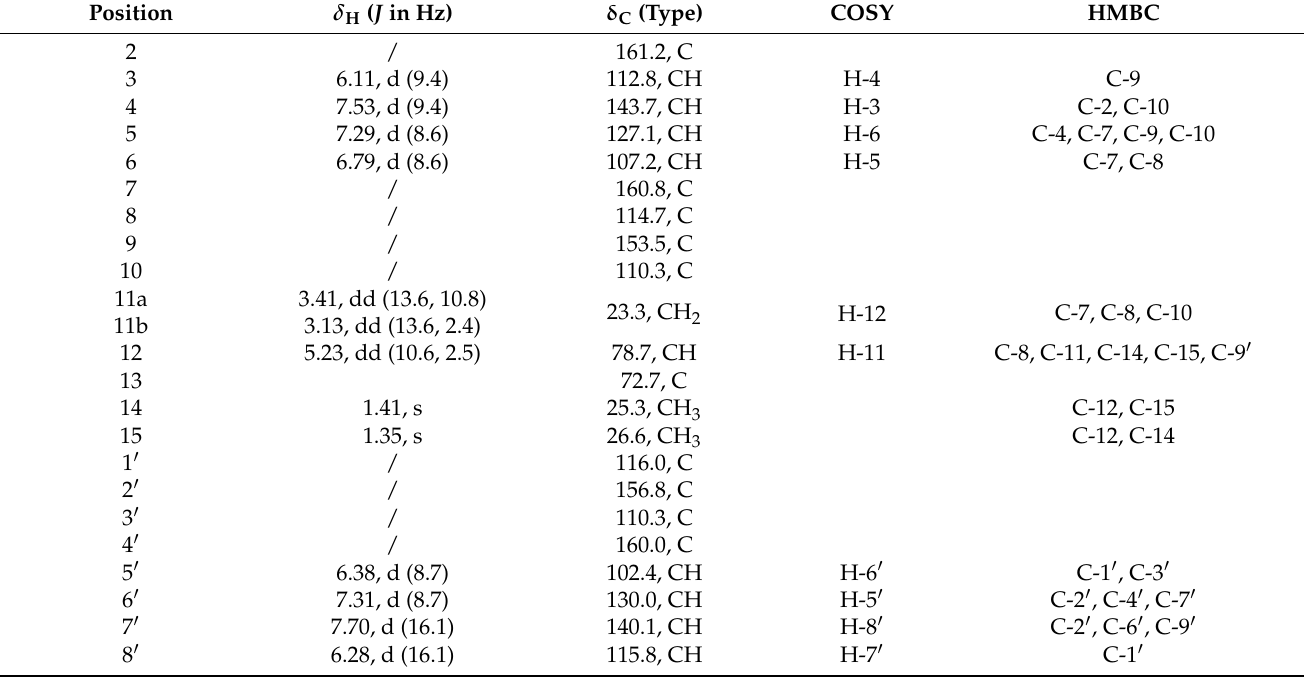
Table 2. 1 H (400 MHz) and 13 C (100 MHz) NMR data of ( 1 ) in CDCl 3 .